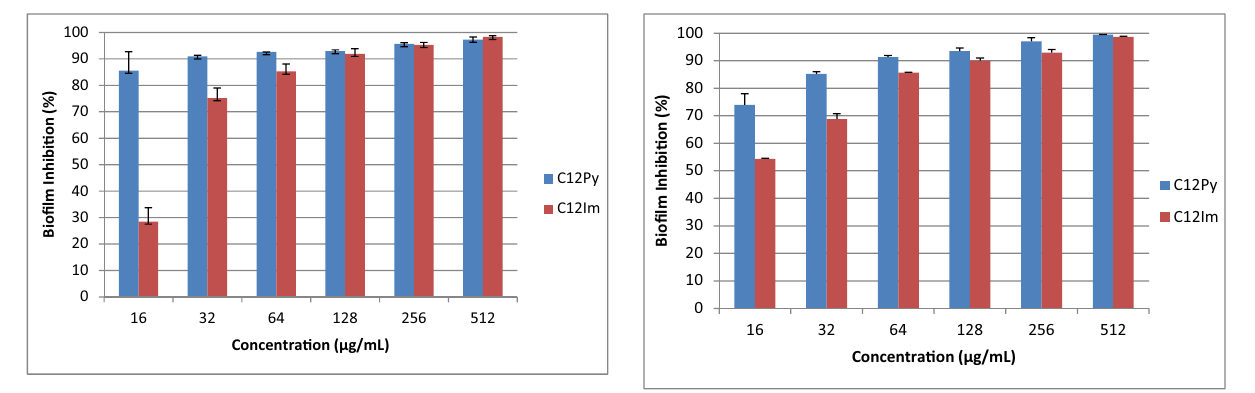
Figure 4: Inhibitory activity of C12 NPs at di ff erent concentrations against the bio fi lm formation of Escherichia coli in 24 h.